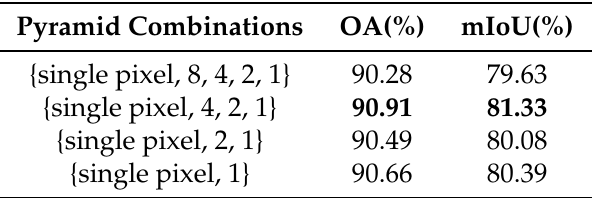
Table 5. Results of the ablation study with different combinations of groups in the RePyAtt module; the values in bold are the best. All results are the average of three runs with maximum epoch = 10 and mini-batch size = 4.